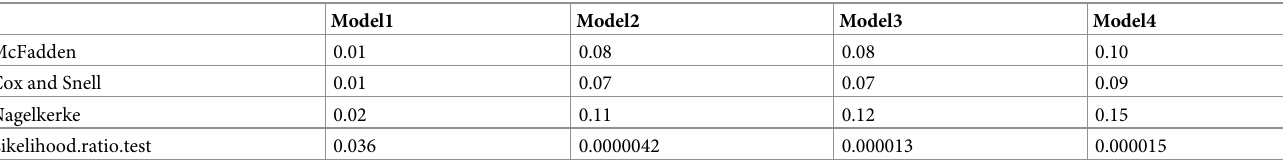
Table 1. McFadden pseudo